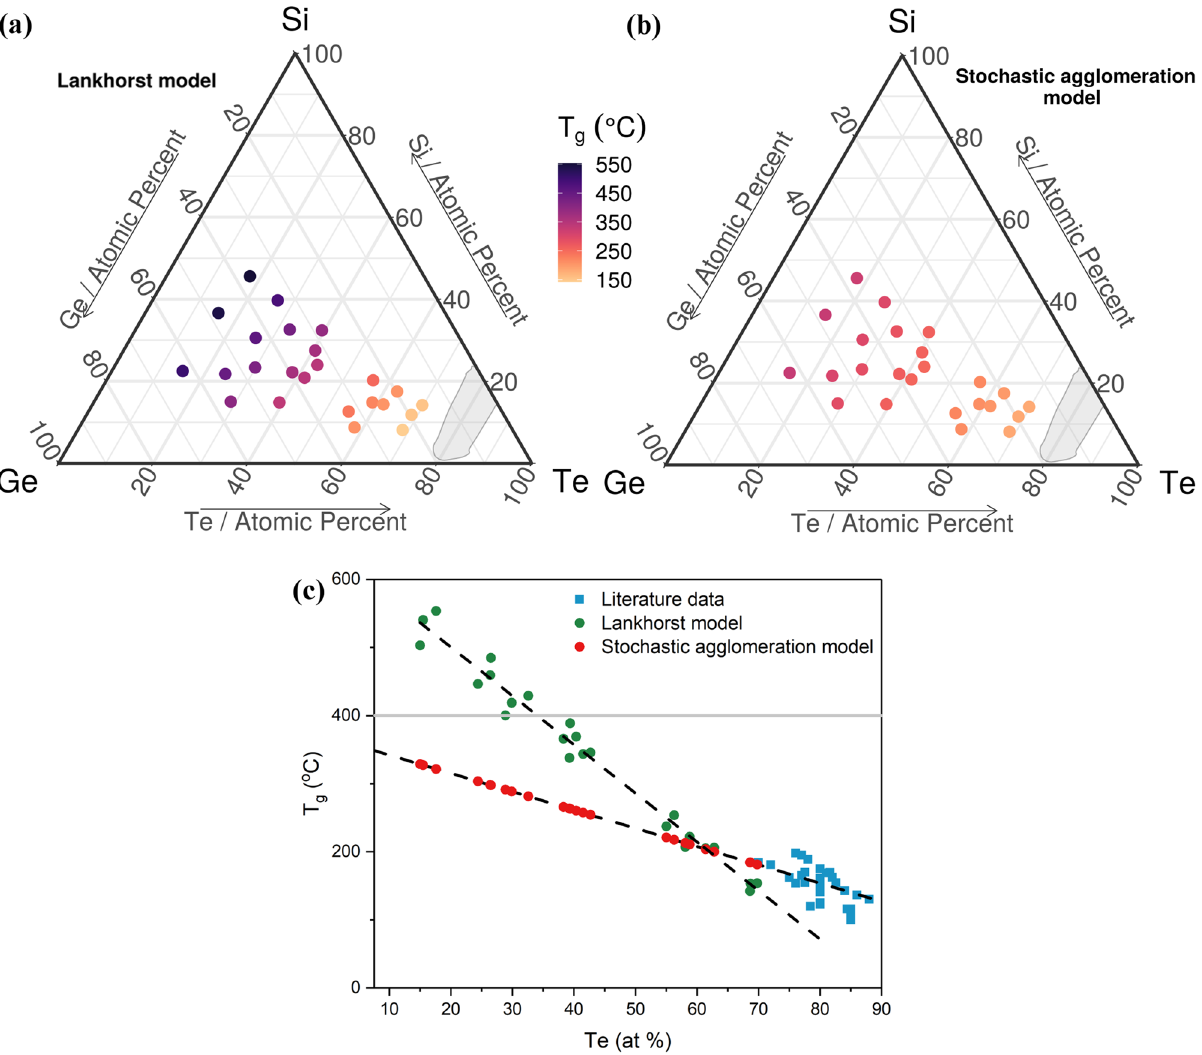
Figure 7. Glass transition temperature of the Si–Ge–Te library. Ternary diagrams showing ( a ) T g computed with the Lankhorst model 56 and ( b ) the stochastic agglomeration model 57,58 , for the sputtered library. ( c ) T g as a function of Te concentration, for arbitrary Si and Ge concentration. Computed values for Lankhorst model ( a ) are shown as green dots, and as red dots for the Stochastic agglomeration model ( b ). The blue squares show experimental data from literature 28,31 . The black dashed lines are guides to the eye. Ternary diagrams were generated with the R software [v. 3.6.3] (R: A language and environment for statistical computing, R Core Team, R Foundation for Statistical Computing, Vienna, Austria (2020) http:// www.R- proje ct. org/.) using the